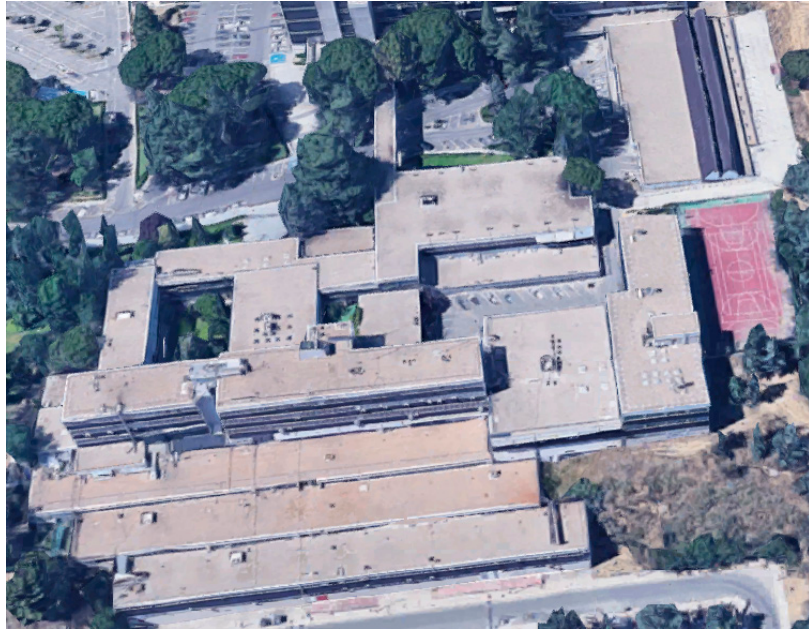
Figure 2. Buildings A and D .